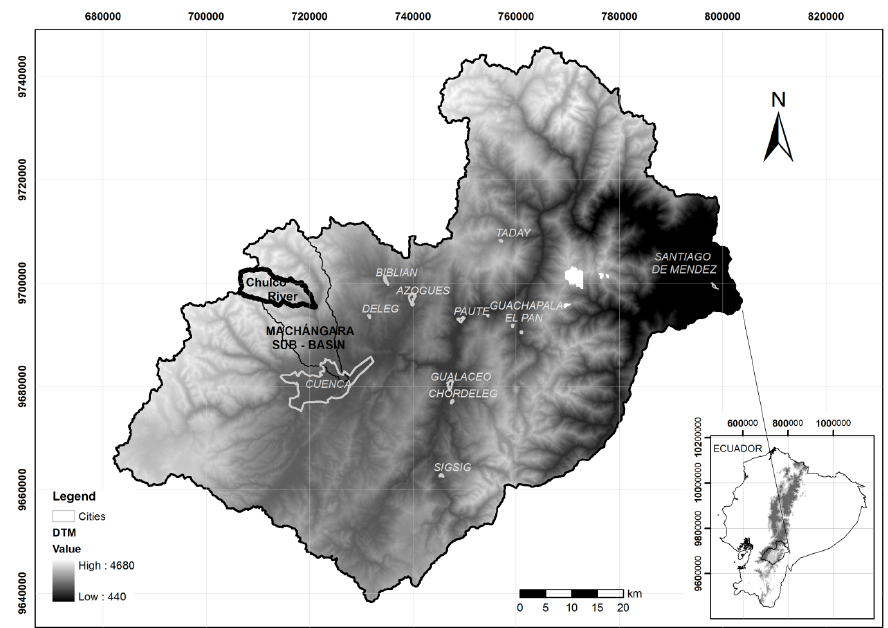
Figure 1. Location of the Chulco river basin in the Paute river basin.